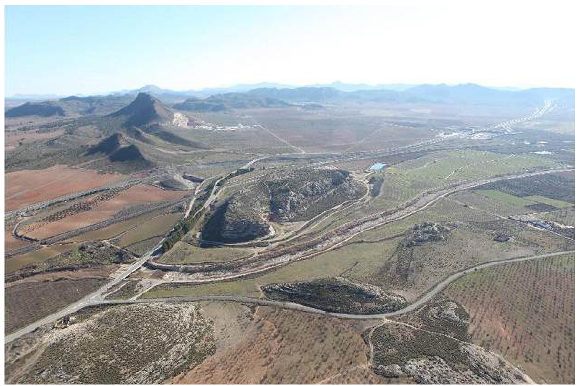
Figure 5. Aerial view of the study area “Tolmo de Minateda” (from Abad Casal et al.,